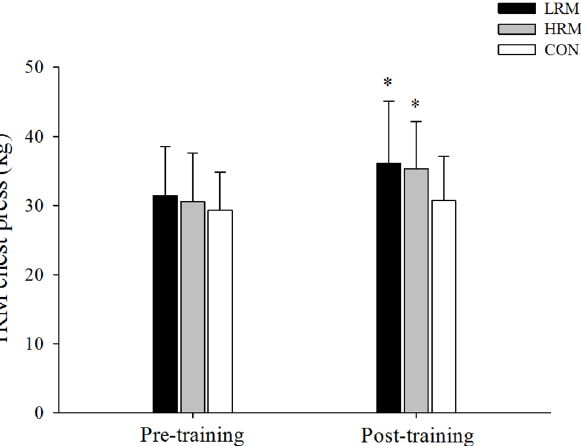
Fig 1. Mean ± SD of chest press maximal strength pre and post 9 week of resistance training. LRM, heavy load – low repetition maximum resistance training group. HRM, moderate load – high repetition maximum resistance training group. CON, control group. ( * ) p < 0.05, higher than pre training.